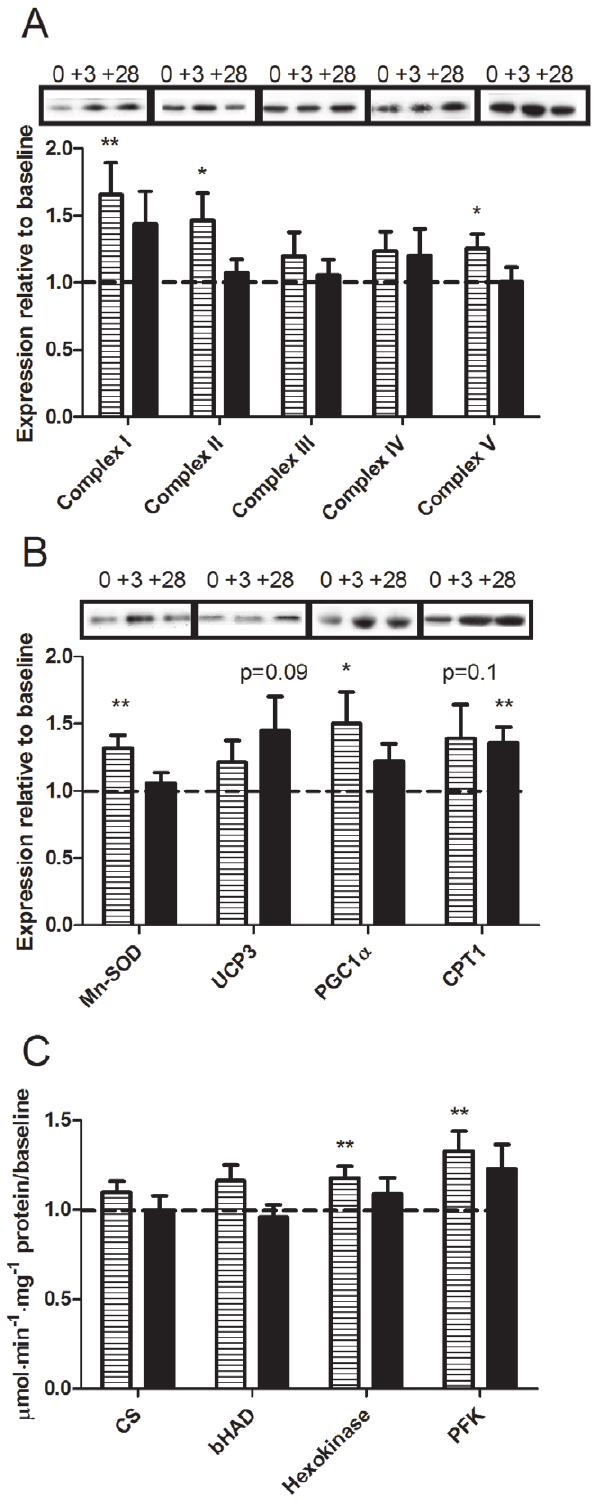
Figure 3. Skeletal muscle protein expression and enzyme activities in response to overfeeding. Skeletal muscle complexes of the electron transport chain (a), Mn-superoxide dismutase (SOD), uncoupling protein-3 (UCP3), PPAR-coactivator 1 a (PGC1 a ), and carnitine palmitoyltransferase (CPT1b) proteins and representative samples of the Western blots (b) and skeletal muscle citrate synthase (CS), hydroxyacyl-CoA dehydrogenase ( b HAD), hexokinase